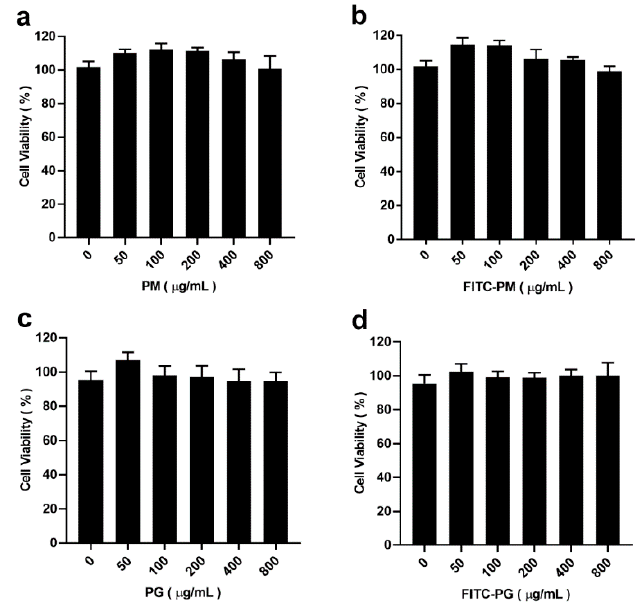
Figure 3. Lack of cytotoxicity of FITC-labeled and unlabeled PM and PG on Caco-2 cells. An MTT assay was used to test the cytotoxicity of PM ( a ), F-PM ( b ), PG ( c ), and F-PG ( d ) on Caco-2 cells.